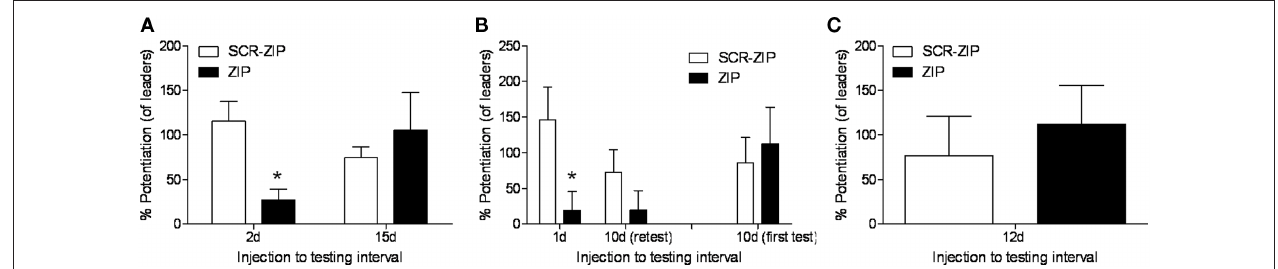
Figure 1 | Percent fear-potentiated startle values relative to the baseline startle stimuli (“leaders”) for the three experiments (Parsons and Davis, 2011) where memory was tested long after infusion of ZiP into the BLA. ZIP disrupted the expression of memory when tested 2 (A) or 1 days (B) after infusion, but not at 10 (B) , 12 (C) , or 15 days